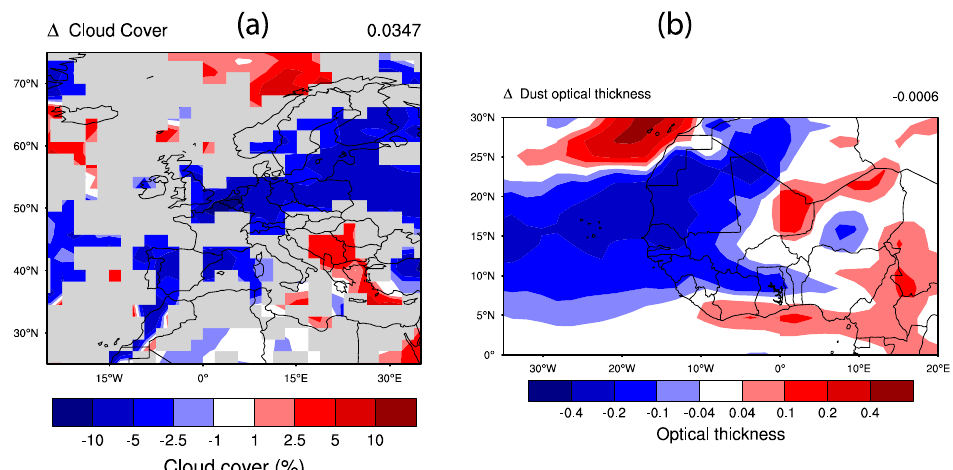
Figure 8. ( a ) Simulated 8-year averaged differences in cloud cover in the European region in July resulting from the BC radiative effect; and ( b ) differences in dust optical thicknesses in eight-year average February conditions. Both results are based on the differences of results for BASE and noBC.